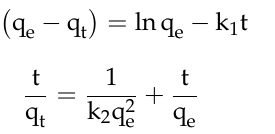
Figure 8. Effect of pH on the adsorption of HA onto RGO-SiO 2 .